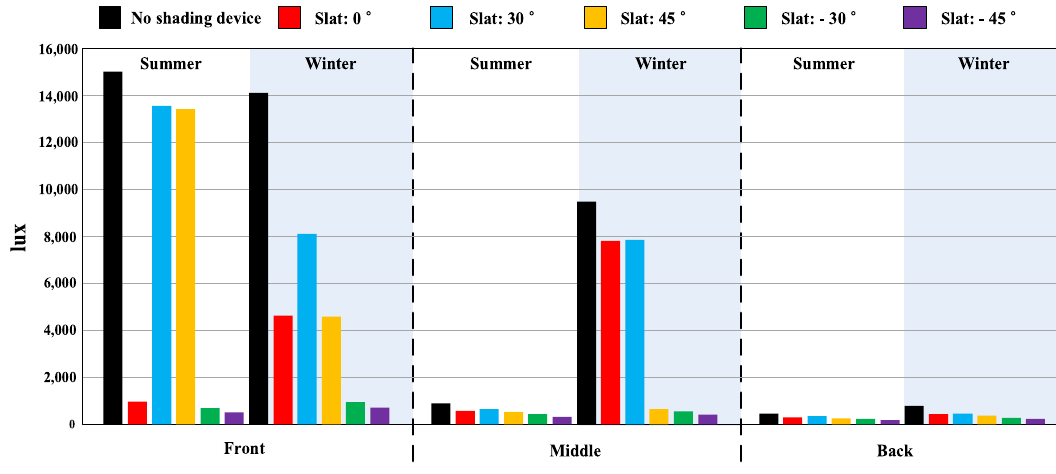
Figure 4. Daylighting performance through the Venetian blind.